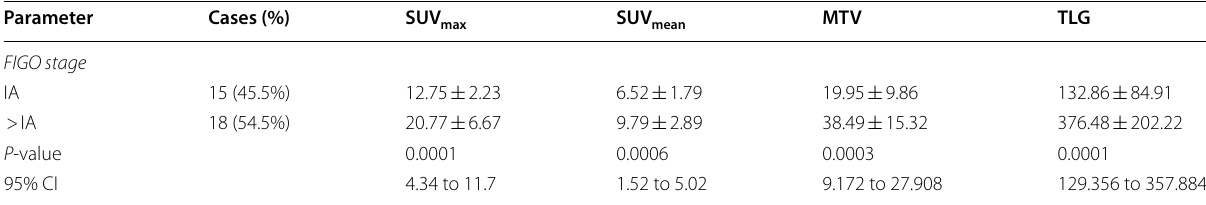
Table 4 PET-CT parameters and EC